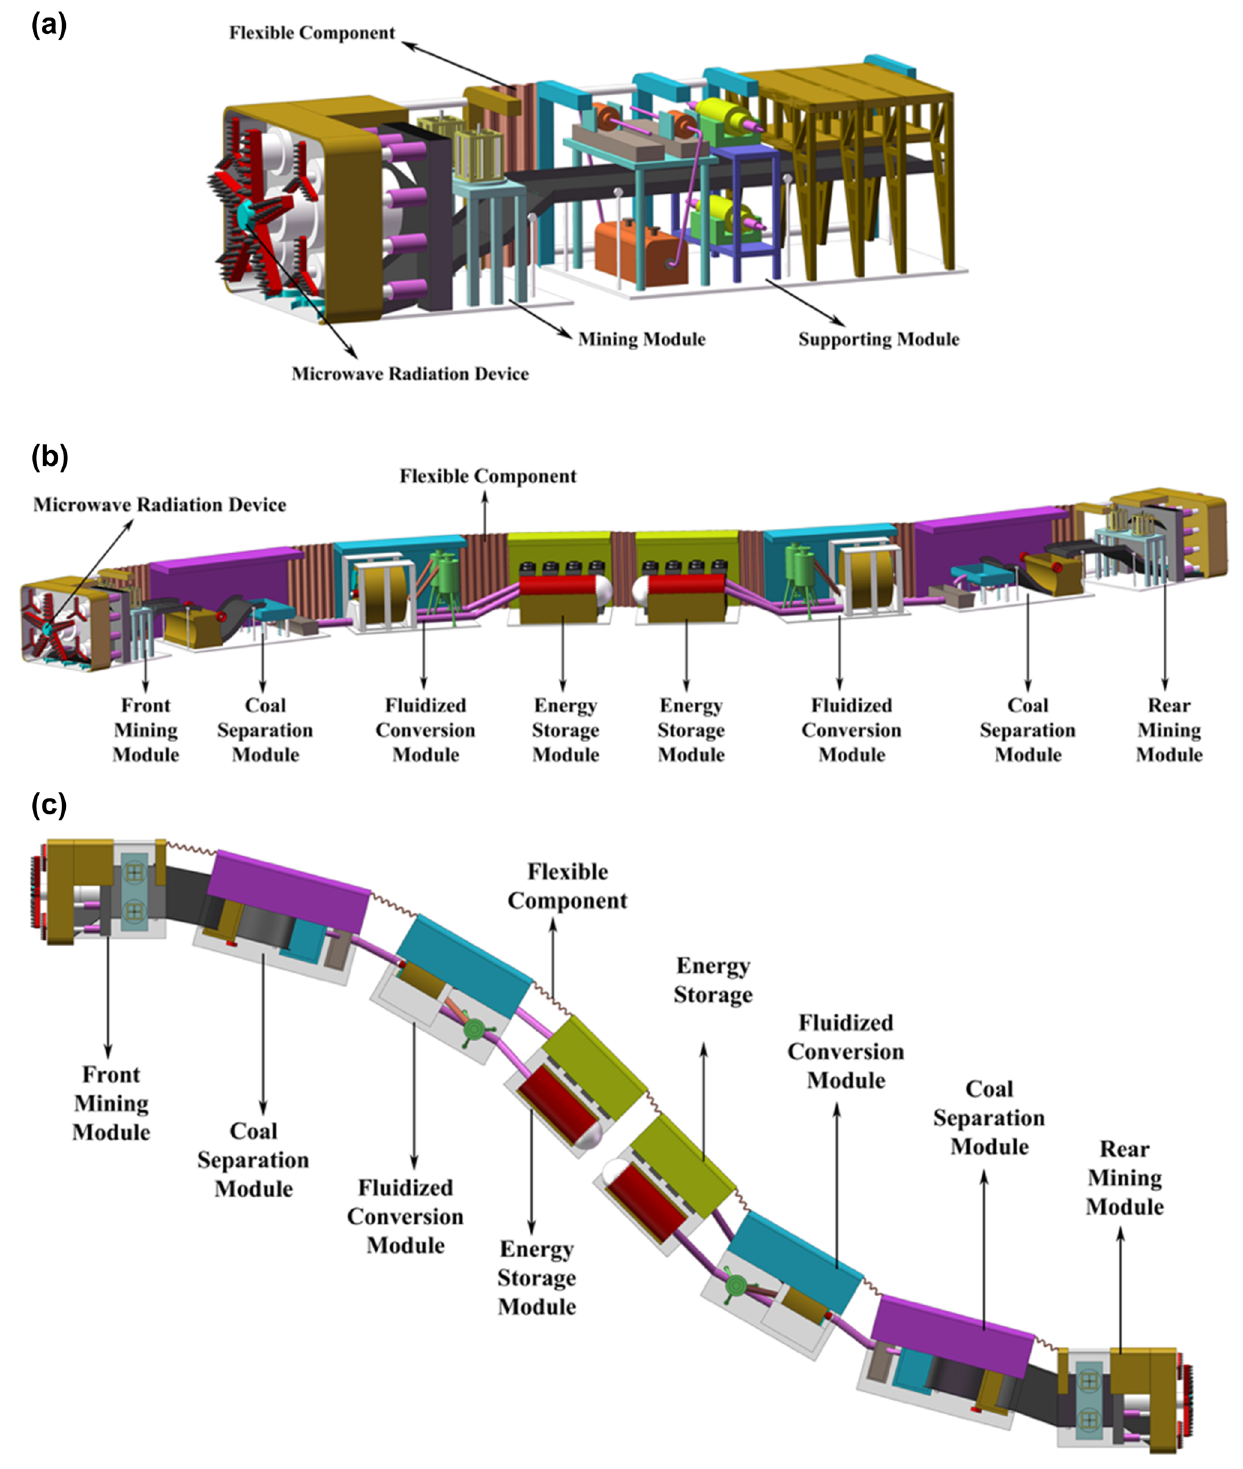
Fig. 3 Schematic of the UAMM and its components: a UAMM-T, b front view of the UAMM-M, and c top view of the